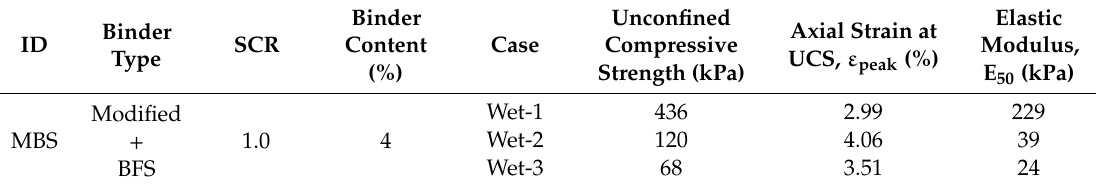
Table 10. Results of unconfined compression test of the repeatedly soaked